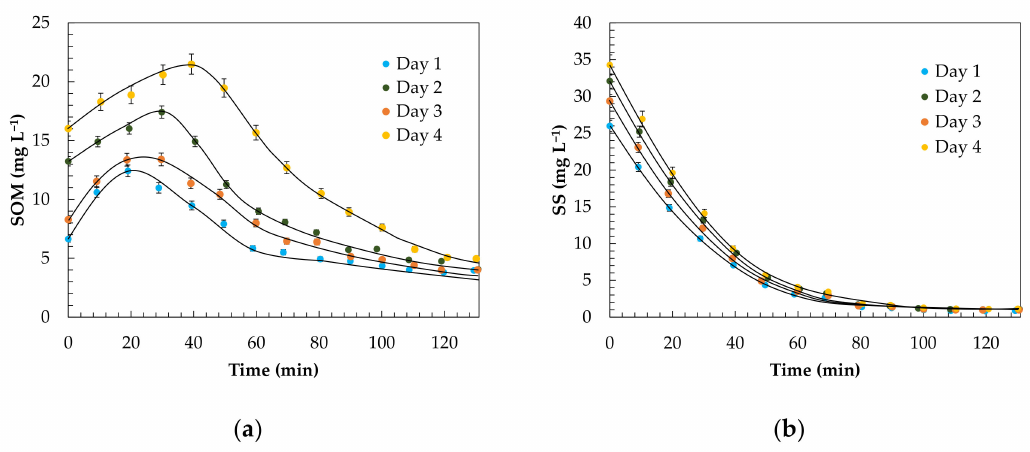
Figure 5. Evolution of the kinetics of SOM removal ( a ) and SS removal ( b ) fit to the first-order serial model. Experimental conditions: F G = 1.6 mg min − 1 , P = 1.5 bar, C O = 6.4 mg L − 1 , pH 0 = 9.0, T = 15.0 ◦ C and V = 30.0 L. 3